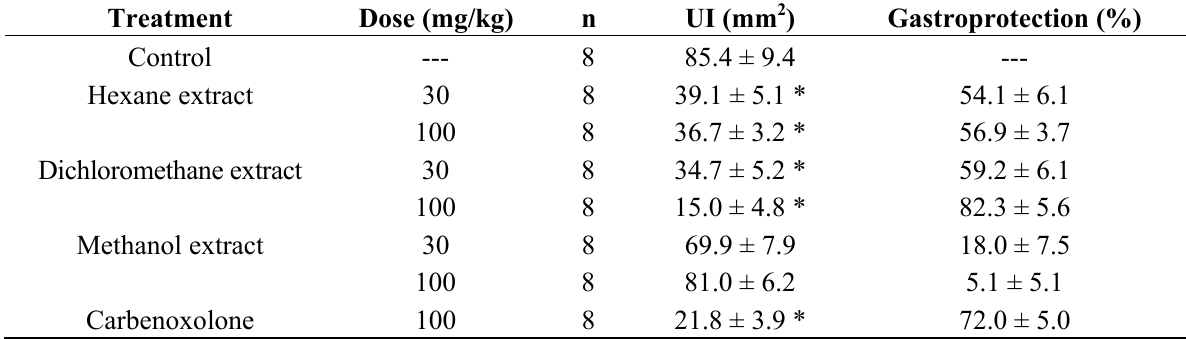
Table 1. Gastroprotective effect of P. pellucida extracts on ethanol-induced ulceration in rats. Treatment